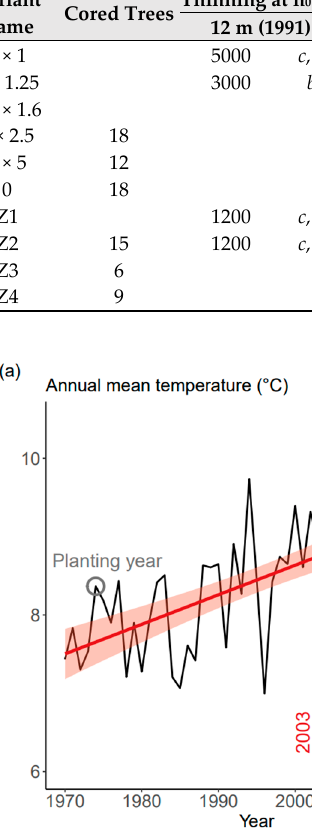
Figure 1. Temperature ( a ) and precipitation ( b ) development from 1970–2020 at the study site. Climate data were obtained from the 1 km × 1 km grid of the DWD Climate Data Center [67]. The dashed lines highlight the drought years considered in this study.